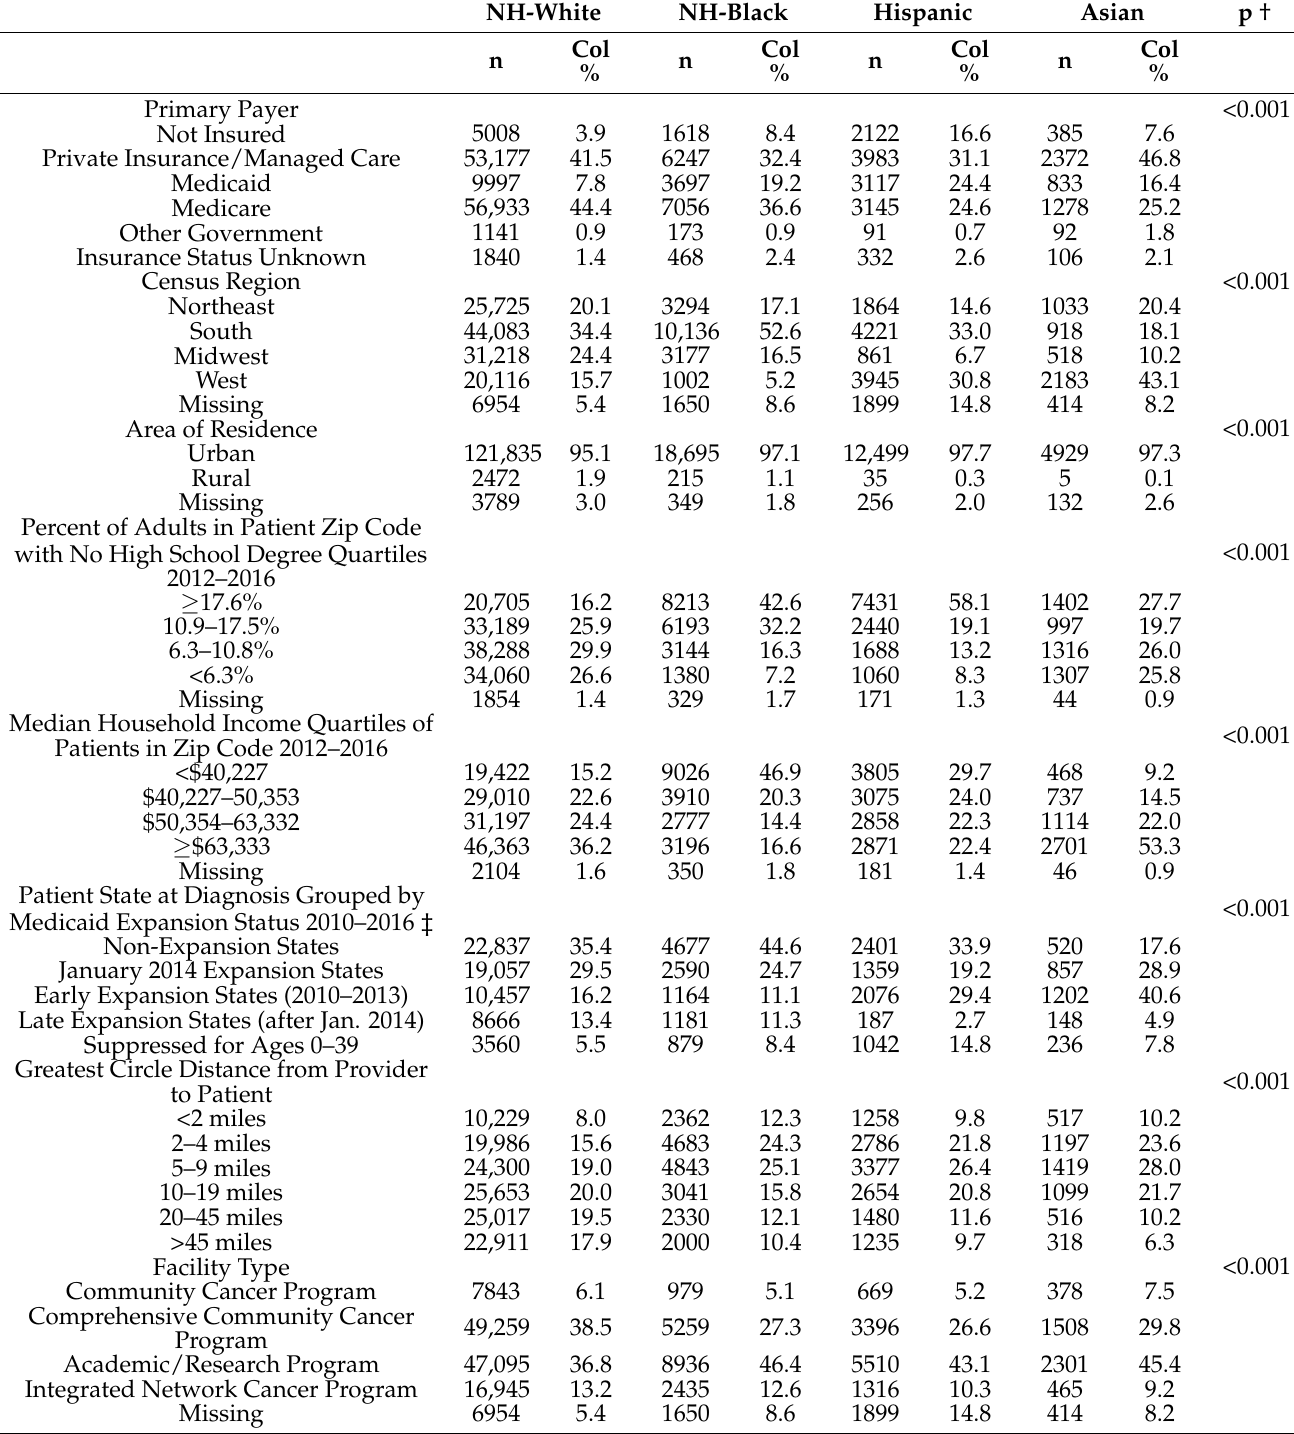
Table 2. Health Care Access Measures Among Metastatic Gynecological Cancer Patients by Race/Ethnicity (n = 165,211)